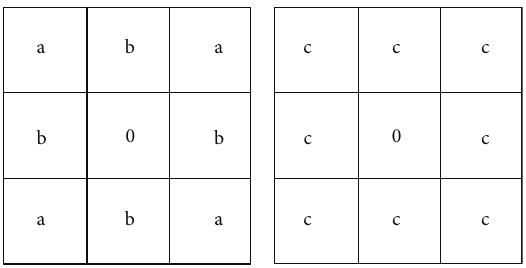
Figure 1: The convolution kernels proposed by Oliviera et al. [9].